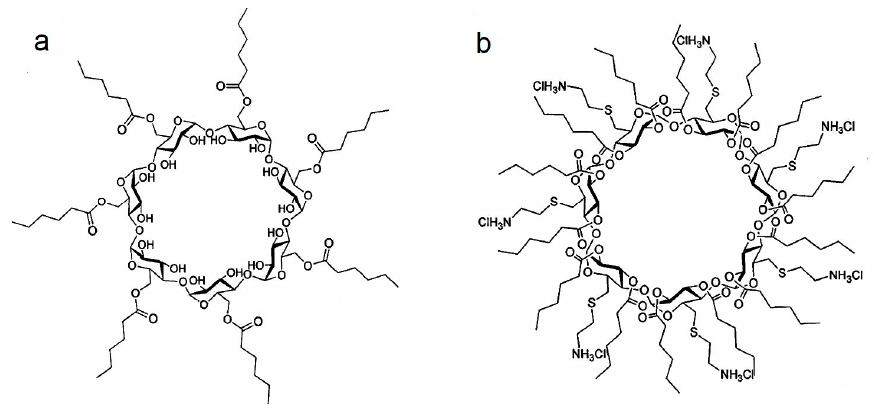
Figure 1. Schematic representation of non-ionic 6OCapro β CD ( a ) and Polycationic PC β CDC6 ( b ).